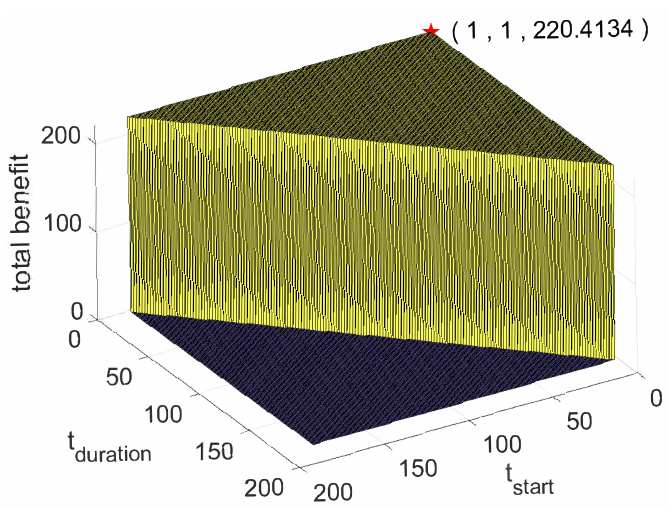
Figure 3. The results of the notraining algorithm.